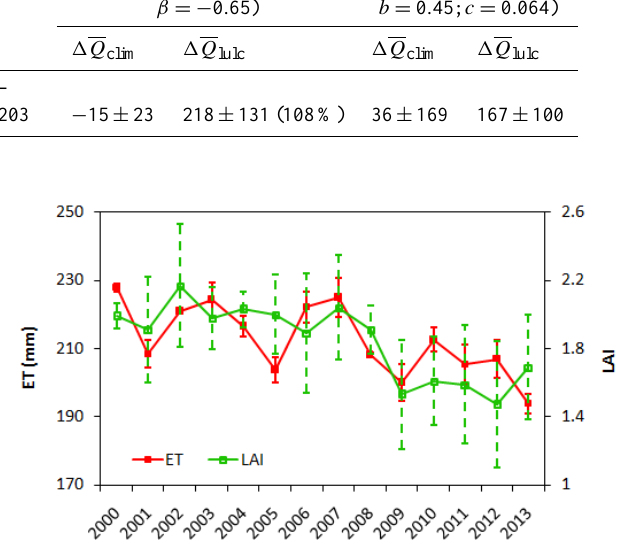
Figure 6. Total MODIS ET (mm per 2 months) and mean LAI during the peak growing season (July–August) over 2000–2013 in the Qinhuai River basin. Vertical lines represent standard deviation across